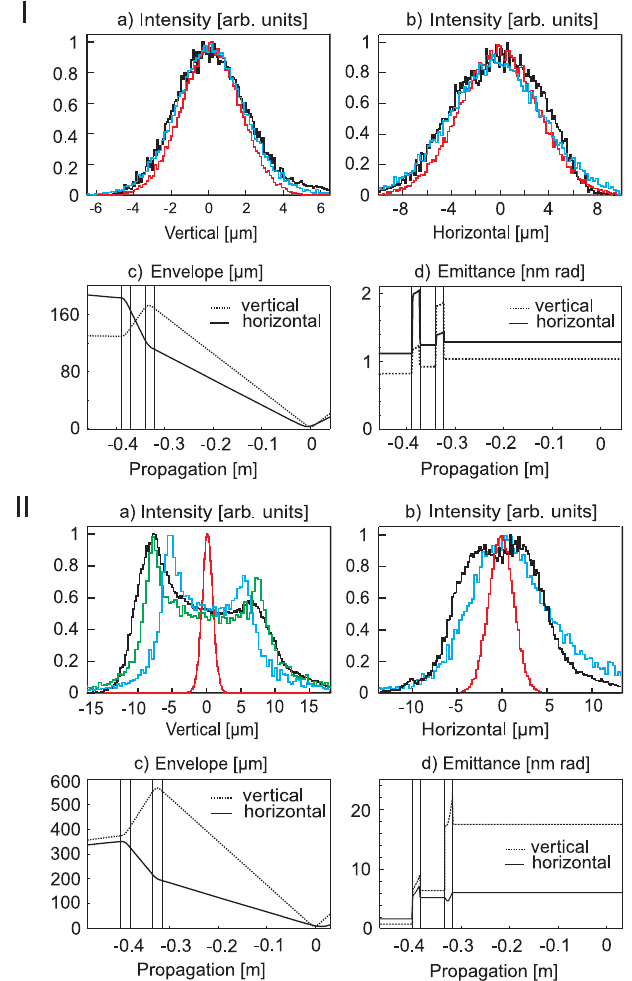
FIG. 5. (Color) Measurements at the Mainz Microtron MAMI are shown with two different beam configurations: The small electron beam configuration (panel I) is shown with the hori- zontal (Ia) and vertical (Ib) beam plane at the waist. The measured beam (black), the calculated beam using expanded fields (blue), and calculated beam for an ideal quadrupole field (red) are shown for comparison. The calculated beam envelope (Ic) and the emittance (Id) are plotted against the propagation direction of the beam. The vertical lines mark the PMQ posi- tions. The large beam configuration is shown correspondingly (panel II). The green curve in panel IIa is computed from the expanded fields, but with a different focal spot slightly moved towards the PMQs by 1 mm or 0.5% of the focal